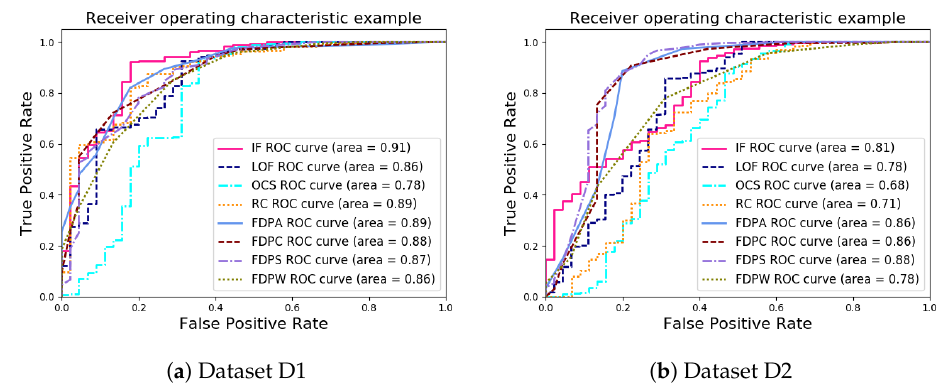
Figure 7. The receiver operating characteristic (ROC) curves and area under curve (AUC) values of synthetic datasets.